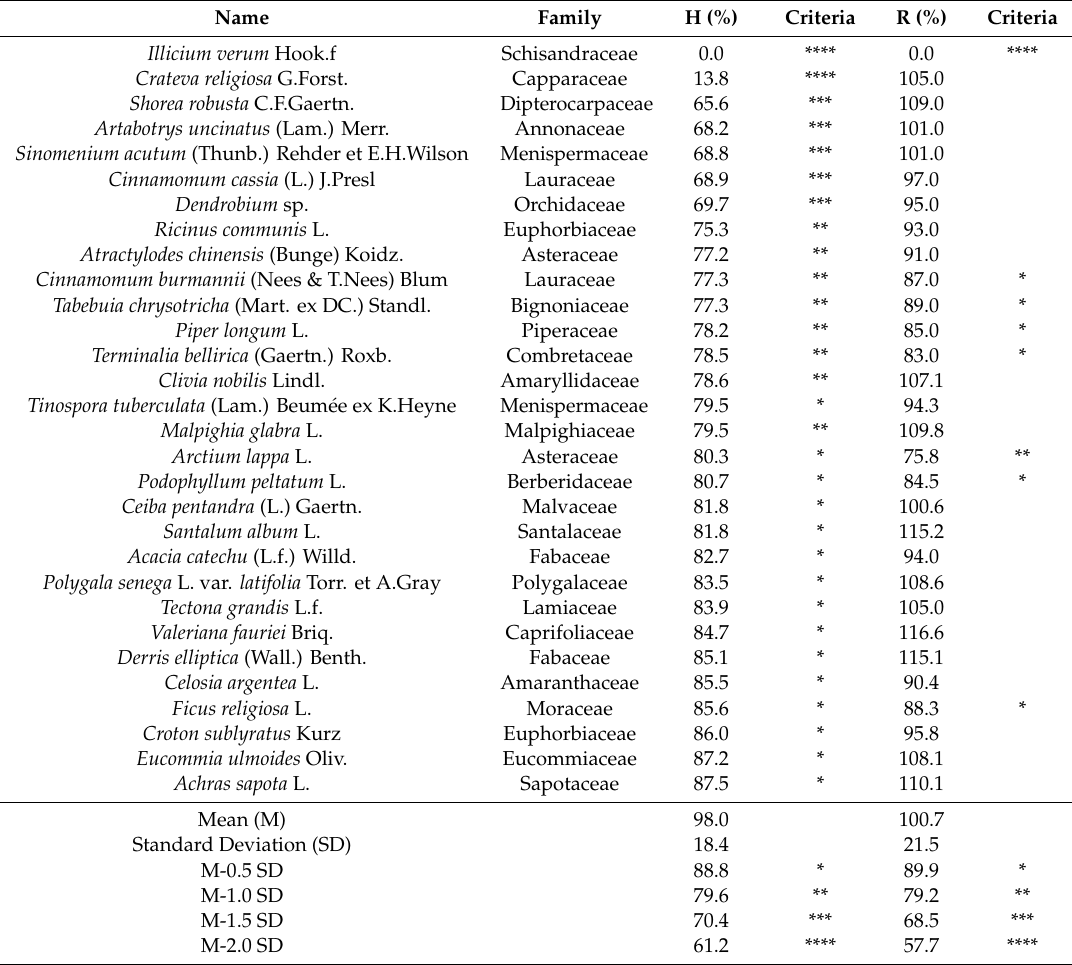
Table 1. Top 30 plant with the most potent inhibitory activity of radicle and hypocotyl growth of lettuce ( L. sativa ) seedlings (% compared to control) through volatiles.